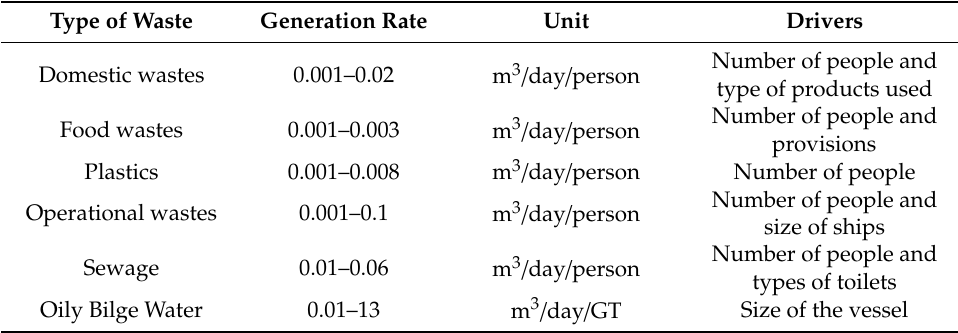
Table 1. Amounts of wastes generated onboard of marine vessels [22,23].